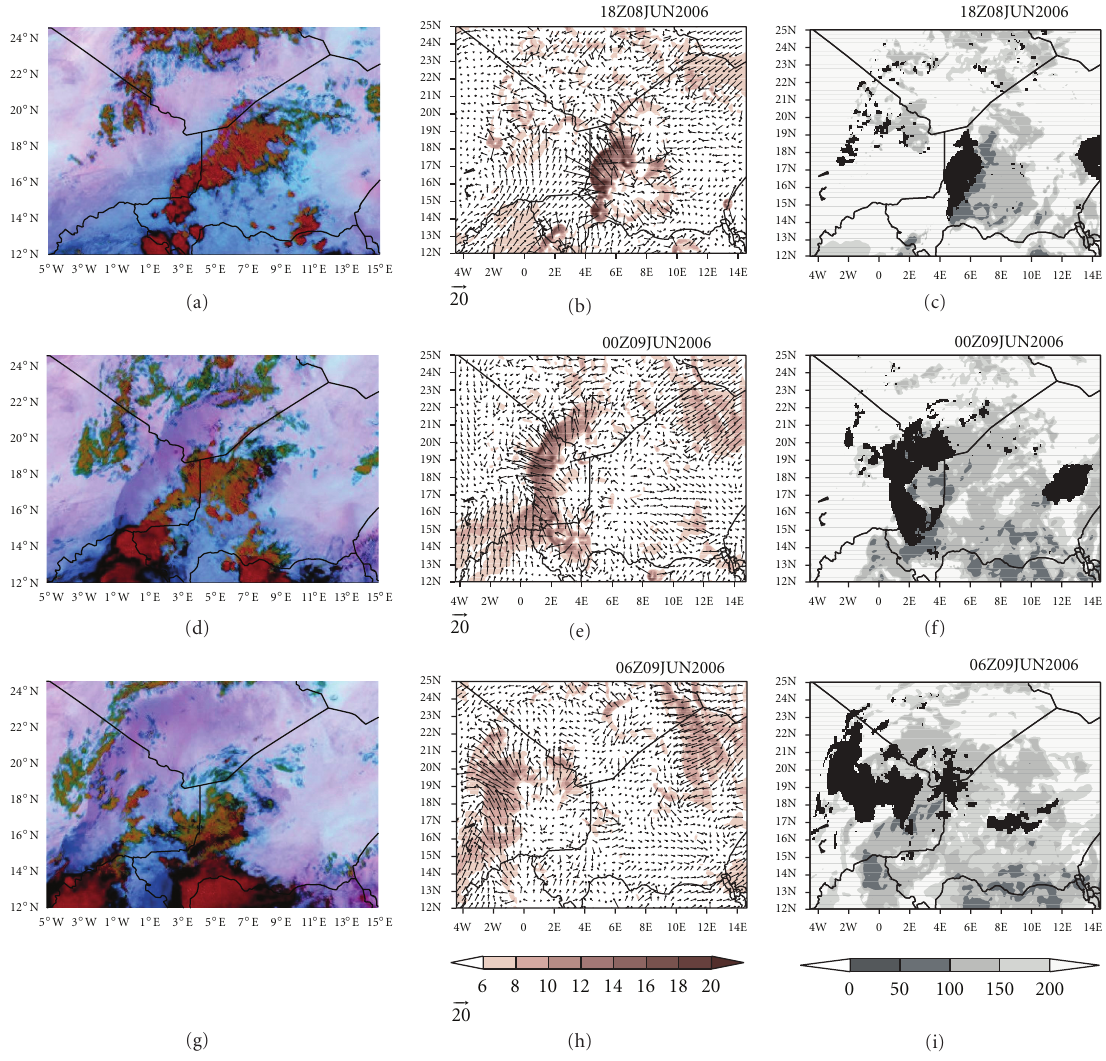
Figure 9: WRF-Chem EXP10 and Seviri dust product on the 8-9th of June. (a, b, and c) 18 UTC on the 9th of June, (d, e, and f) 00 UTC, (g, h, and i) 06UTC. Left column: SEVIRI dust product. Center column: Wind speed (shaded) and direction (vectors) at 10m height. Right column: Outgoing Longwave Radiation (shaded), and AOT > 0.5 (black